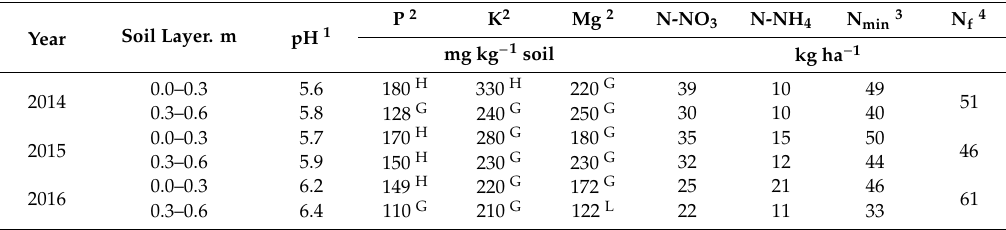
Table 1. Soil agrochemical properties before maize sowing.